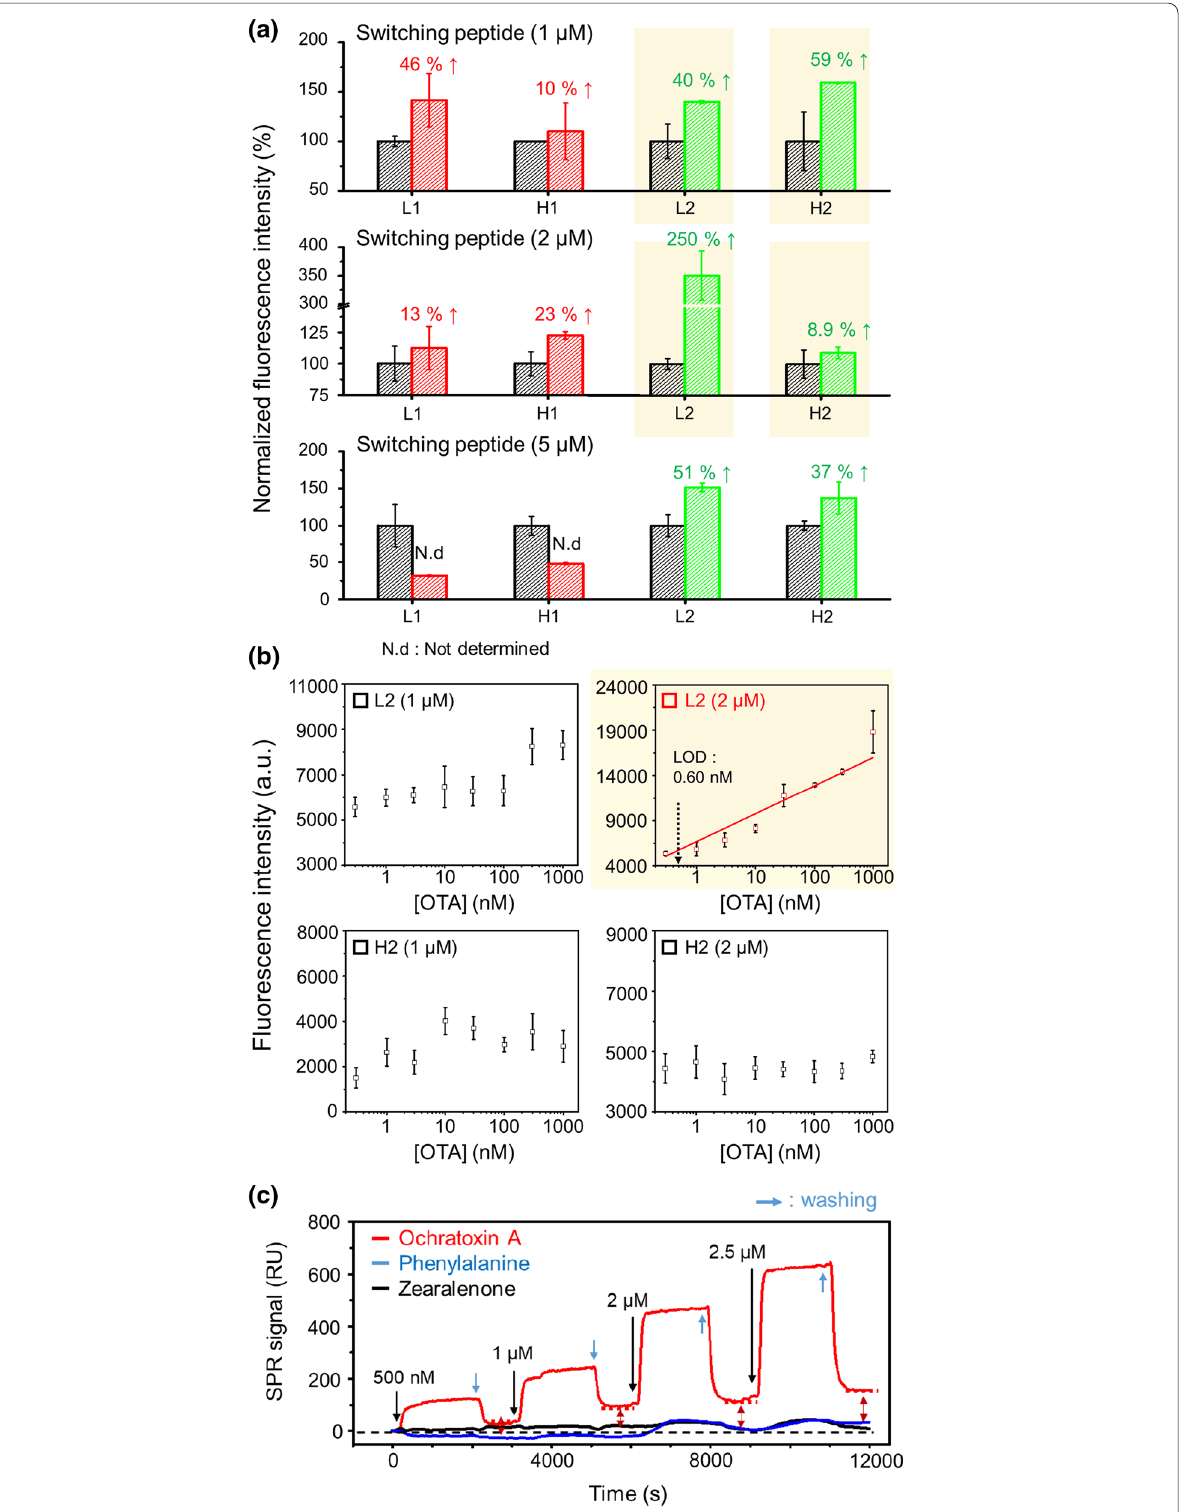
Fig. 3 Releasing test of switching peptides to the Fab region of IgG. a Fluorescence responses of four kinds of switching peptides for the detection of OTA. b Quantitative one‑step immunoassay by the measurement of fluorescence intensity in solution after OTA treatment. c SPR sensorgrams of OTA and two comparing chemicals of phenylalanine and zearalenone using immobilized anti‑OTA antibodies. d Selectivity test of the one‑step immunoassay based on switching peptide for OTA using two comparing chemicals of phenylalanine and